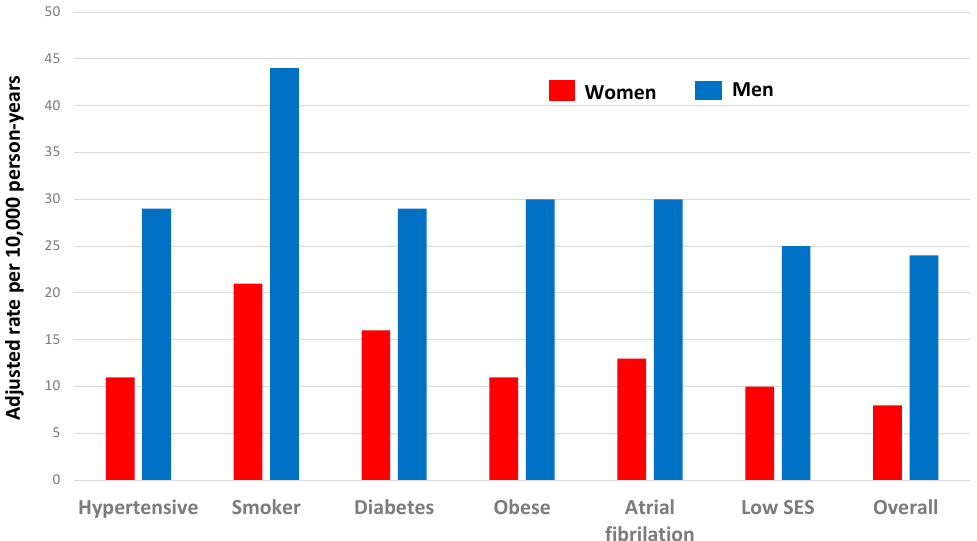
Figure 2. Incidence rates for myocardial infarction amongst people with specific risk factors and overall, in the UK Biobank, by sex, adjusted for age and other CVD risk factors. The study population was 471,988 people without a history of CVD followed up for 7 years [3].